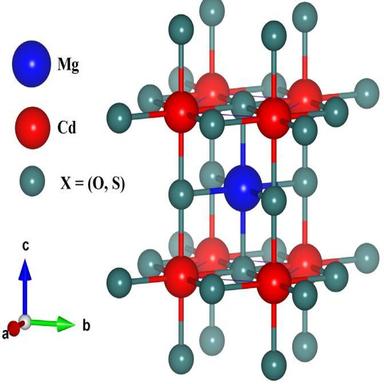
Computed unit cell structure for MgCdX2 (X ¼ O, S) respectively.